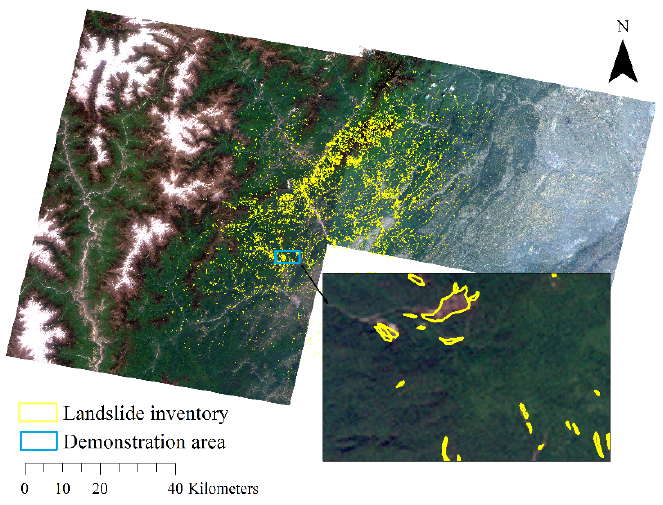
Figure 6. Landslide inventories in the Lushan earthquake-triggered landslide